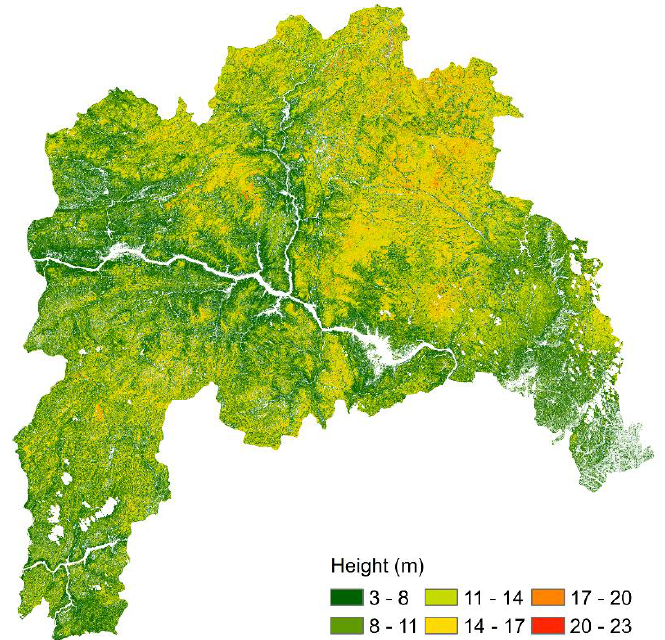
Figure 13. Forest canopy height predicted by the Random Forest model.